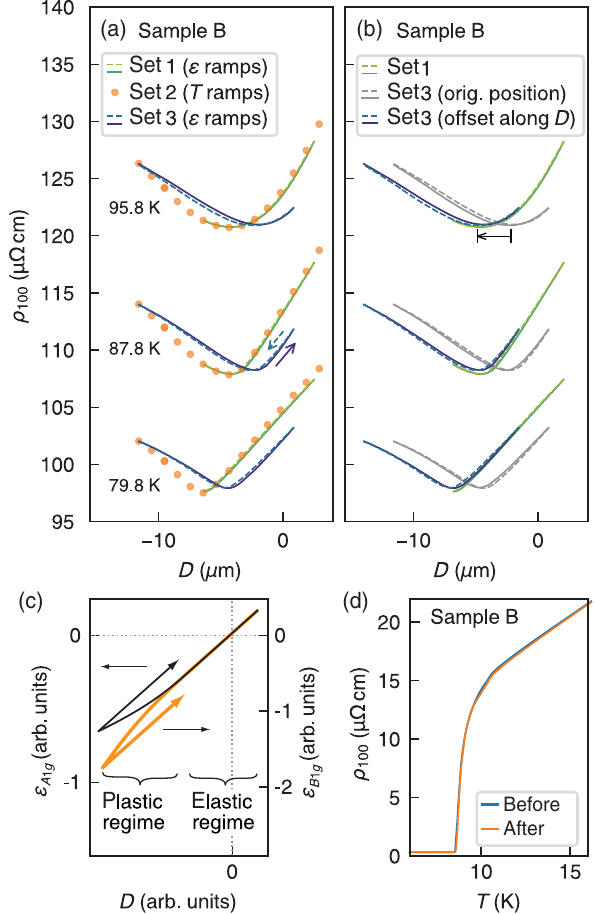
FIG. 9. Plastic deformation of the platform. (a) ρ 100 of sample B versus displacement D applied to the platform. The datasets were taken in the following order. (1) Strain ramps at fixed